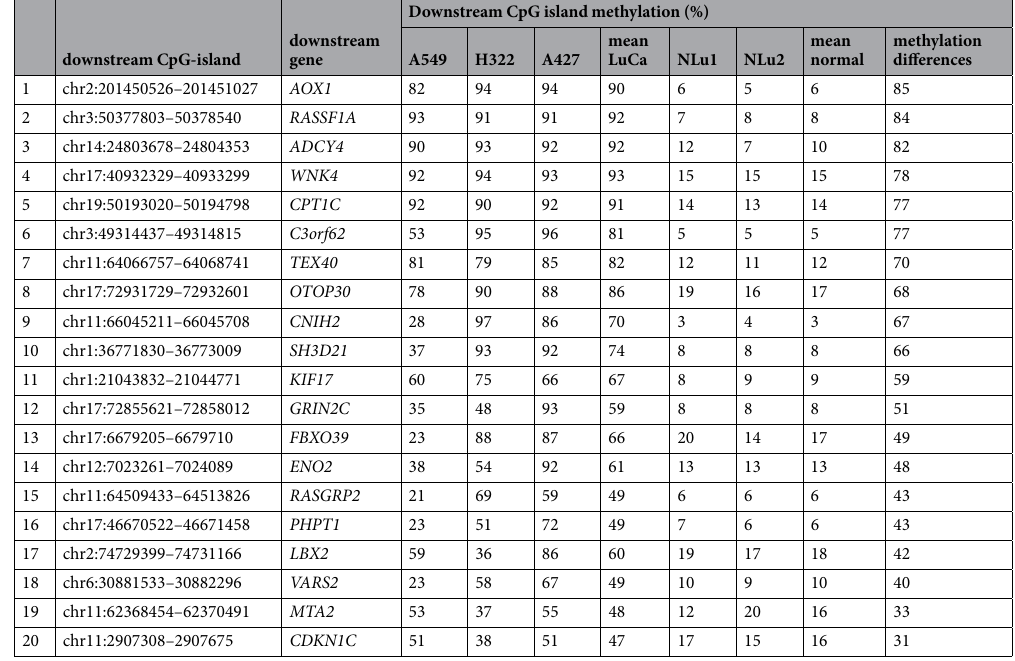
Table 2. Top 20 tandem-oriented hypermethylated downstream